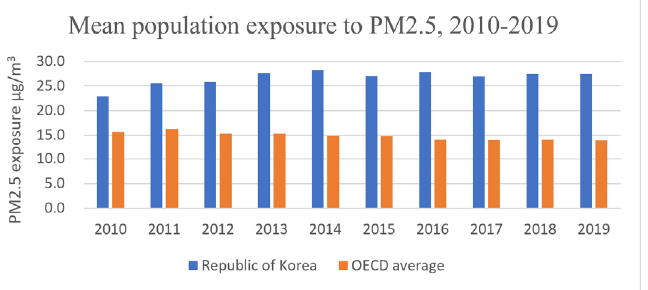
Figure 1. Mean population exposure to PM2.5 µg/m 3 , 2010–2019, South Korea and the OECD average [10].